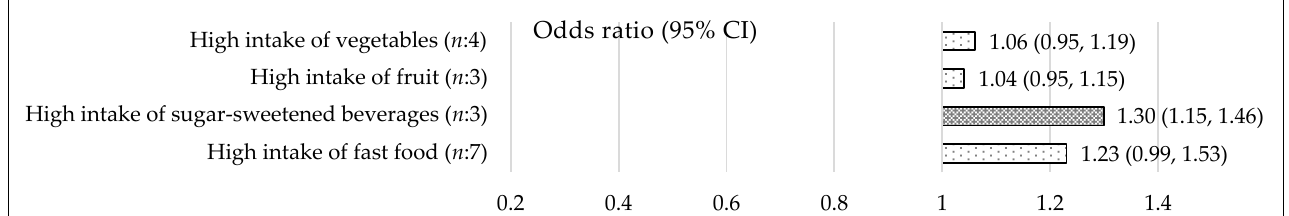
Figure 3. Association between a high intake of eight different food and beverages categories and risk of overweight/obesity in children 5–11 years. OR < 1 = decreased risk of overweight/obesity, OR > 1 = increased risk of overweight/obesity. Dark shades are significant ( p ≤ 0.05). White shades are not significant. The forest-plots for each food or beverages category is available in Supplementary Figures S16–S24.